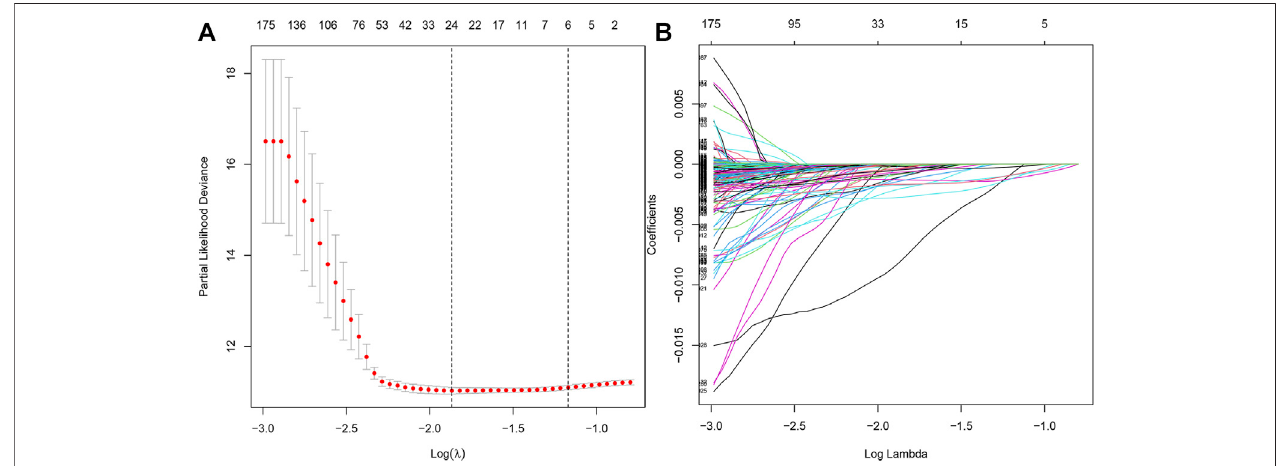
FIGURE 3 | LASSO regression analysis model construction. (A) LASSO coef fi cient distribution of differentially expressed genes. (B) Partial likelihood bias of the LASSO coef fi cient